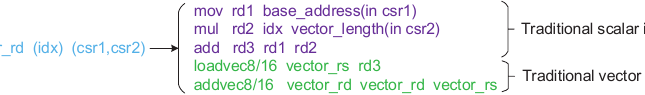
Figure 10. The load-rs-add-rd-vec8/16 instruction equivalent.